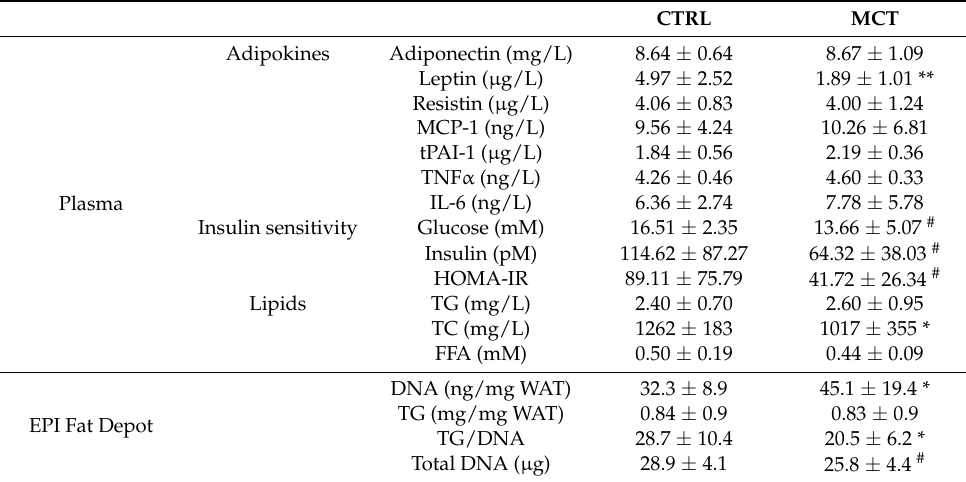
Table 4. Fasting plasma parameters and EPI fat depot traits at PN day 98 in mice 1